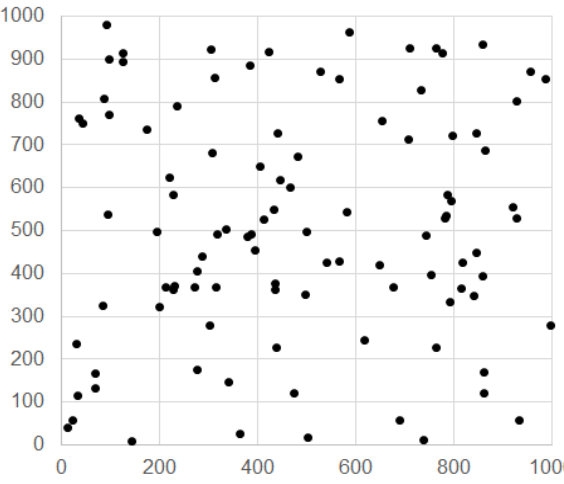
Figure 5. Deployment map with 100 things (nodes).